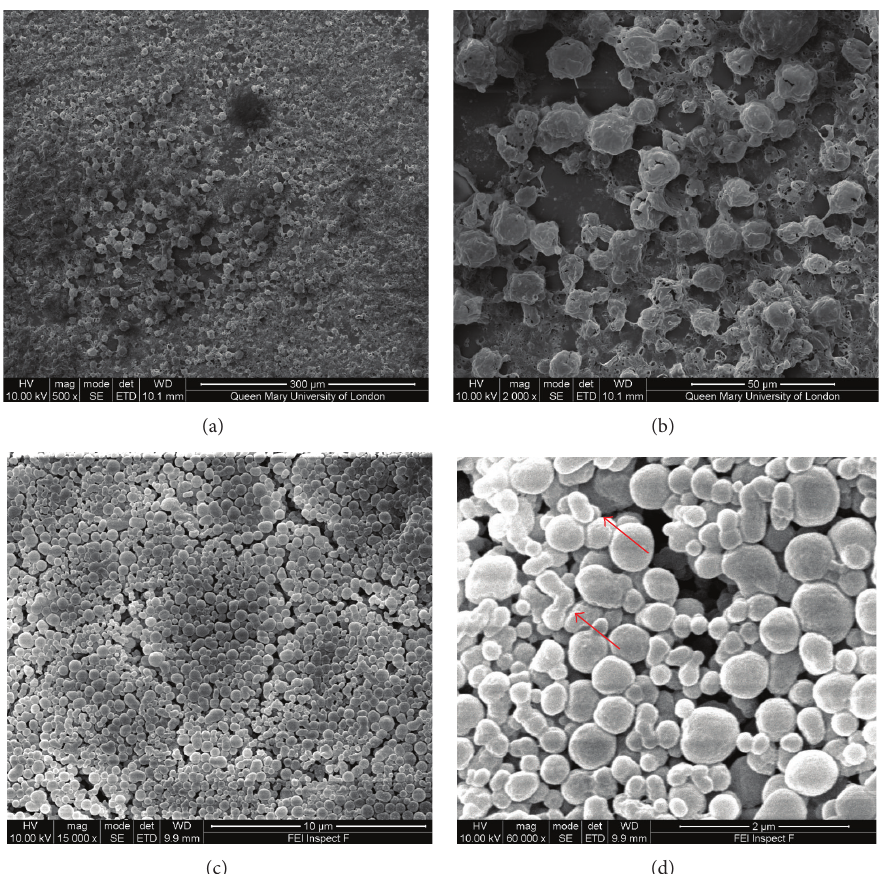
Figure 3: SEM images of encapsulated octadecane particles using (a, b) SDS and (c, d) BSA as surfactants, respectively. ∗ Particle diameter and distribution expressed as mean ± SD of at least 50 particles per sample of random measurement of SEM images. The symbols ( ↖ ) pointed out the spheres with irregular shape.